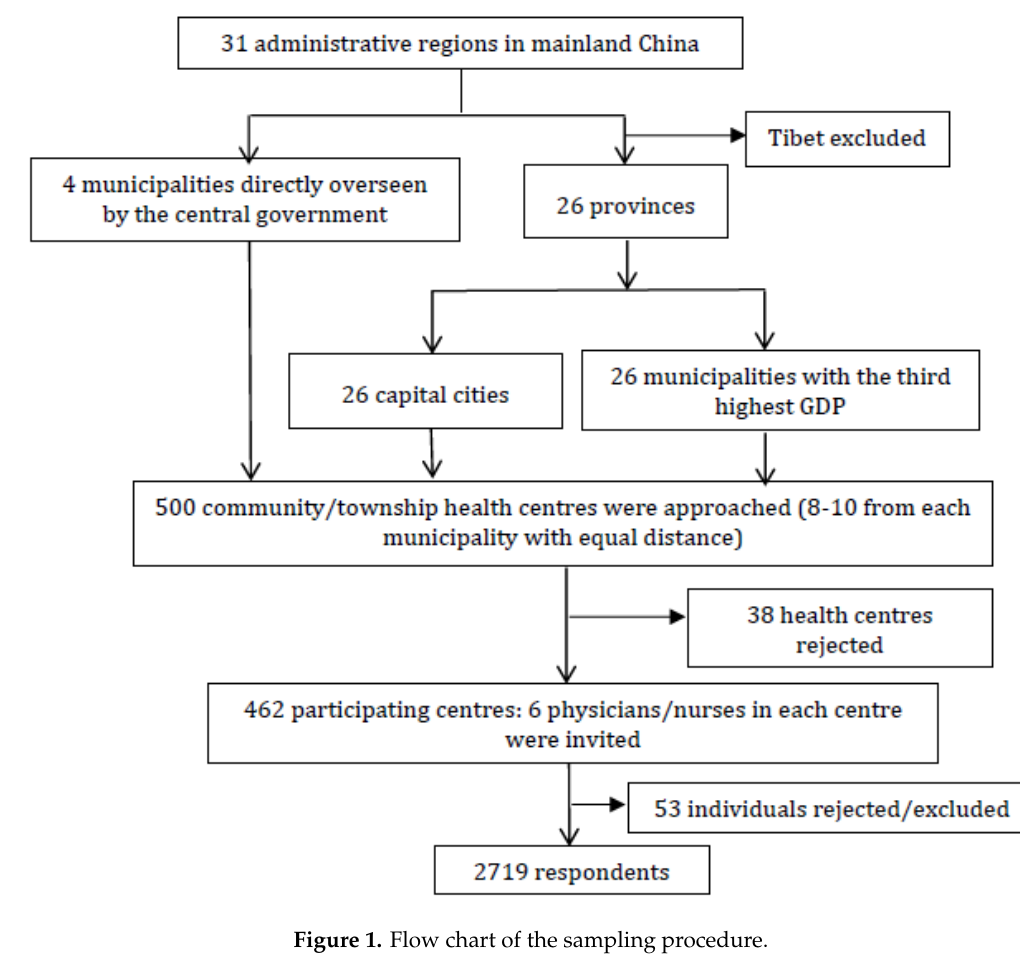
Figure 1. Flow chart of the sampling procedure.